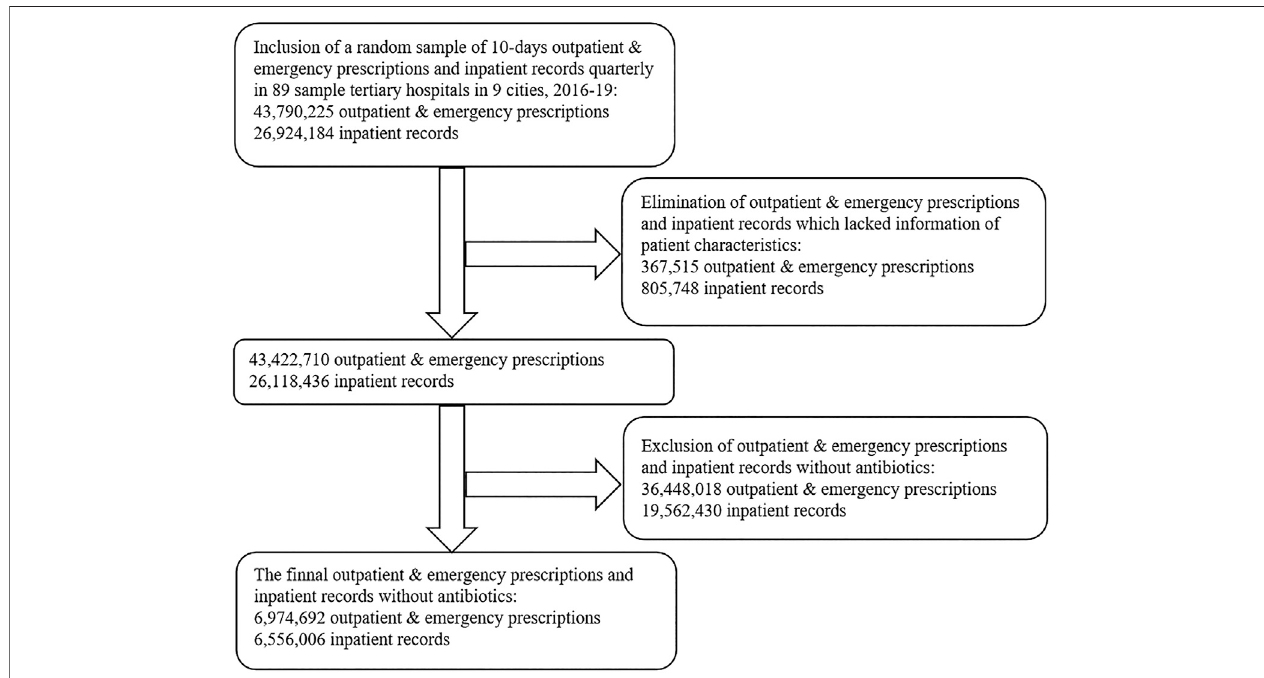
FIGURE 1 | Flow diagram showing the process of selecting prescriptions and records with antibiotics based on the Cooperation Project Database of Hospital Prescriptions.